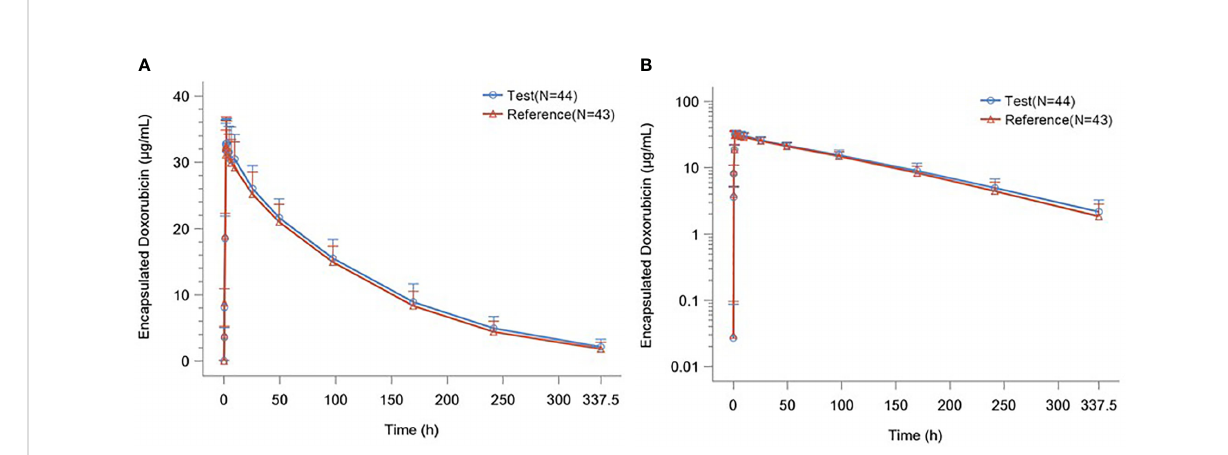
FIGURE 3 (A) Plasma Concentration – time Curves of Liposome Encapsulated Doxorubicin. (B) Plasma Concentration – time Semilogarithmic Curves of Liposome Encapsulated